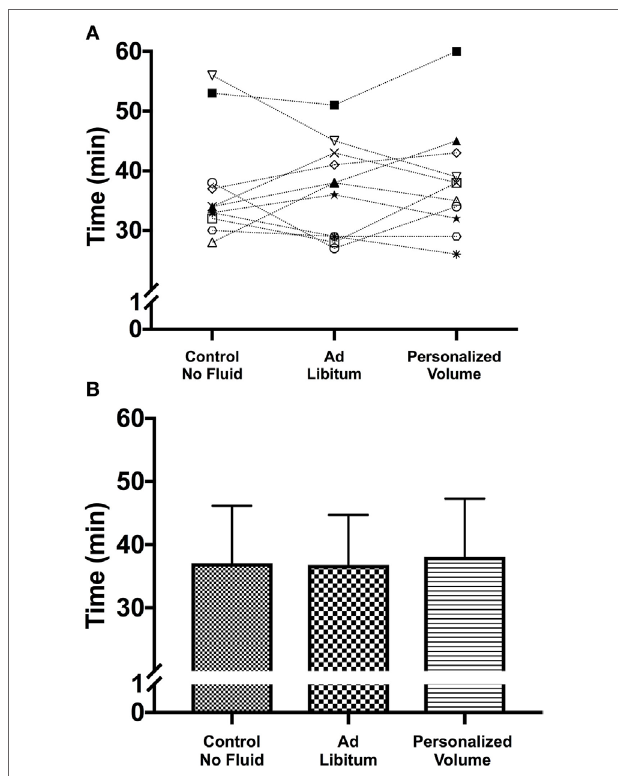
FigUre 1 | (a) Individual performance in the time-to-exhaustion trial in the heat for the three different hydration strategies. Despite the absence of significant differences among hydration strategies it is possible to identify participants whose performance was positively or negatively affected by the personalization of the hydration strategy. (b) Mean and SD for each of the experimental